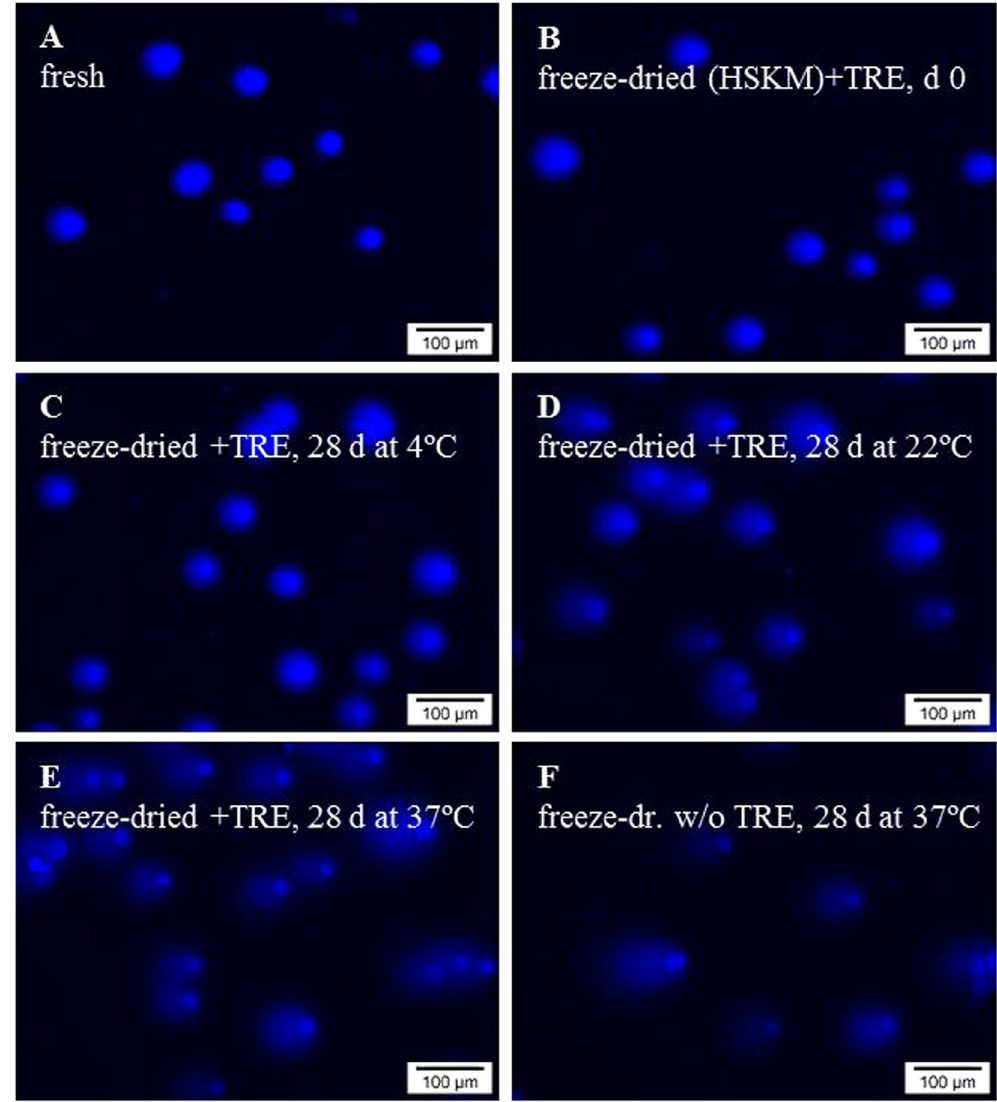
Figure 5. Micrographs acquired with the ‘comet assay’ for assessing chromatin integrity and DNA damage; for fresh fibroblasts ( A ) as well as fibroblasts which were subjected to freeze-drying with trehalose ( B – E ) or without protective agents ( F ) and different storage conditions in the dried state. Freeze-dried specimens were rehydrated and analyzed directly after freeze-drying ( B ) as well as after 28 d storage at 4 °C ( C ), 22 °C ( D ) and 37 °C ( E , F ). Cells embedded in agarose were lysis-treated and subjected to alkaline electrophoresis, after which they were stained with the DNA intercalating dye Hoechst. Increased DNA damage is evident as longer ‘comet tails’ and increased fluorescence intensity in the ‘tail’ at expense of the ‘head’ or nuclear region